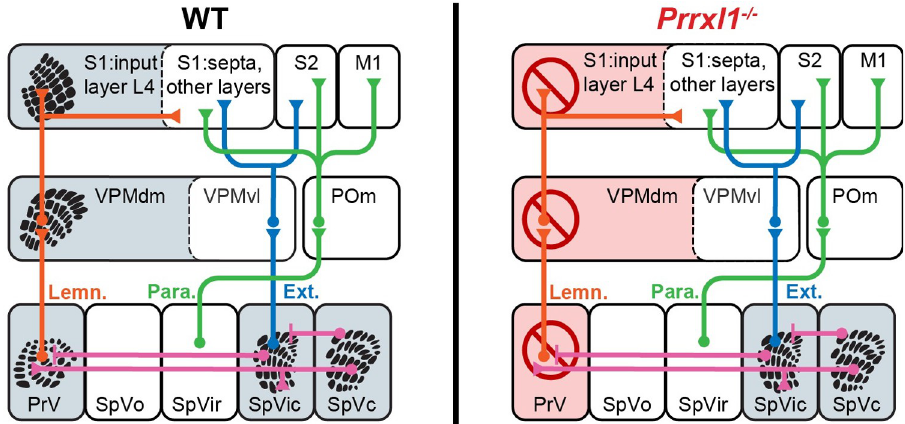
Fig 4. Prrxl1 deletion results in genetic ablation of somatotopy selectively along the lemniscal pathway. Somatotopic patterning and feedforward projections of the lemniscal (Lemn., orange) paralemniscal (Para., green), and extralemniscal (Ext., blue) pathways in WT and Prrxl1 - /— mice. In Prrxl1 - /— mice, topographic arrangement into somatotopy is spared in SpVic and SpVc but abolished in PrV, VPM, and SI cortex—throughout the lemniscal pathway. Shaded regions mark nuclei with somatotopy present in wildtype animals. Barrel-like somatotopic patterns redrawn from [13–15].